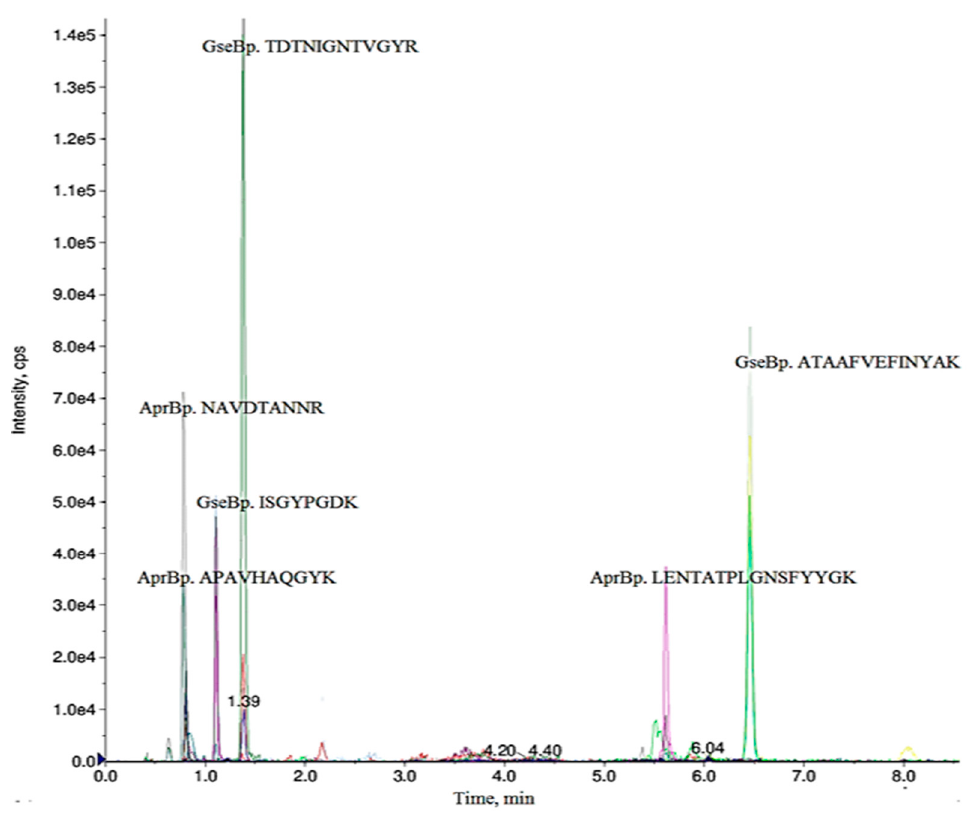
Figure 1. Ion chromatograms of selected MRM transitions monitored for serine proteases AprBp and GseBp. Three different peptides were considered for each protein confirmation. The MRM transitions 655.82/993.51 for GseBp peptide TDTNIGNTVGYR, 487.83/860.42 for AprBp peptide NAVDTANNR, with the best sensitivity and a lower interference/matrix effect were taken for further quantification in blind samples.